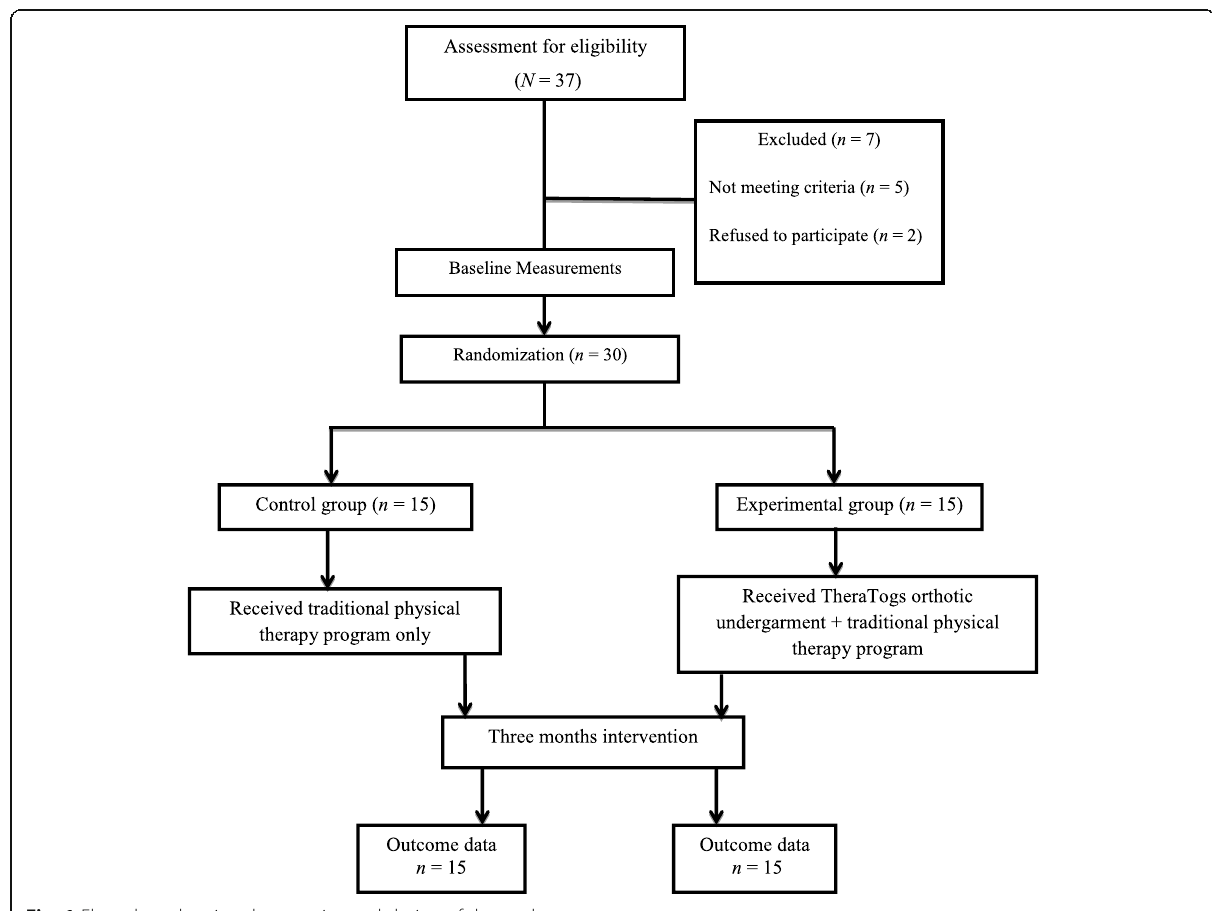
Fig. 1 Flow chart showing the experimental design of the